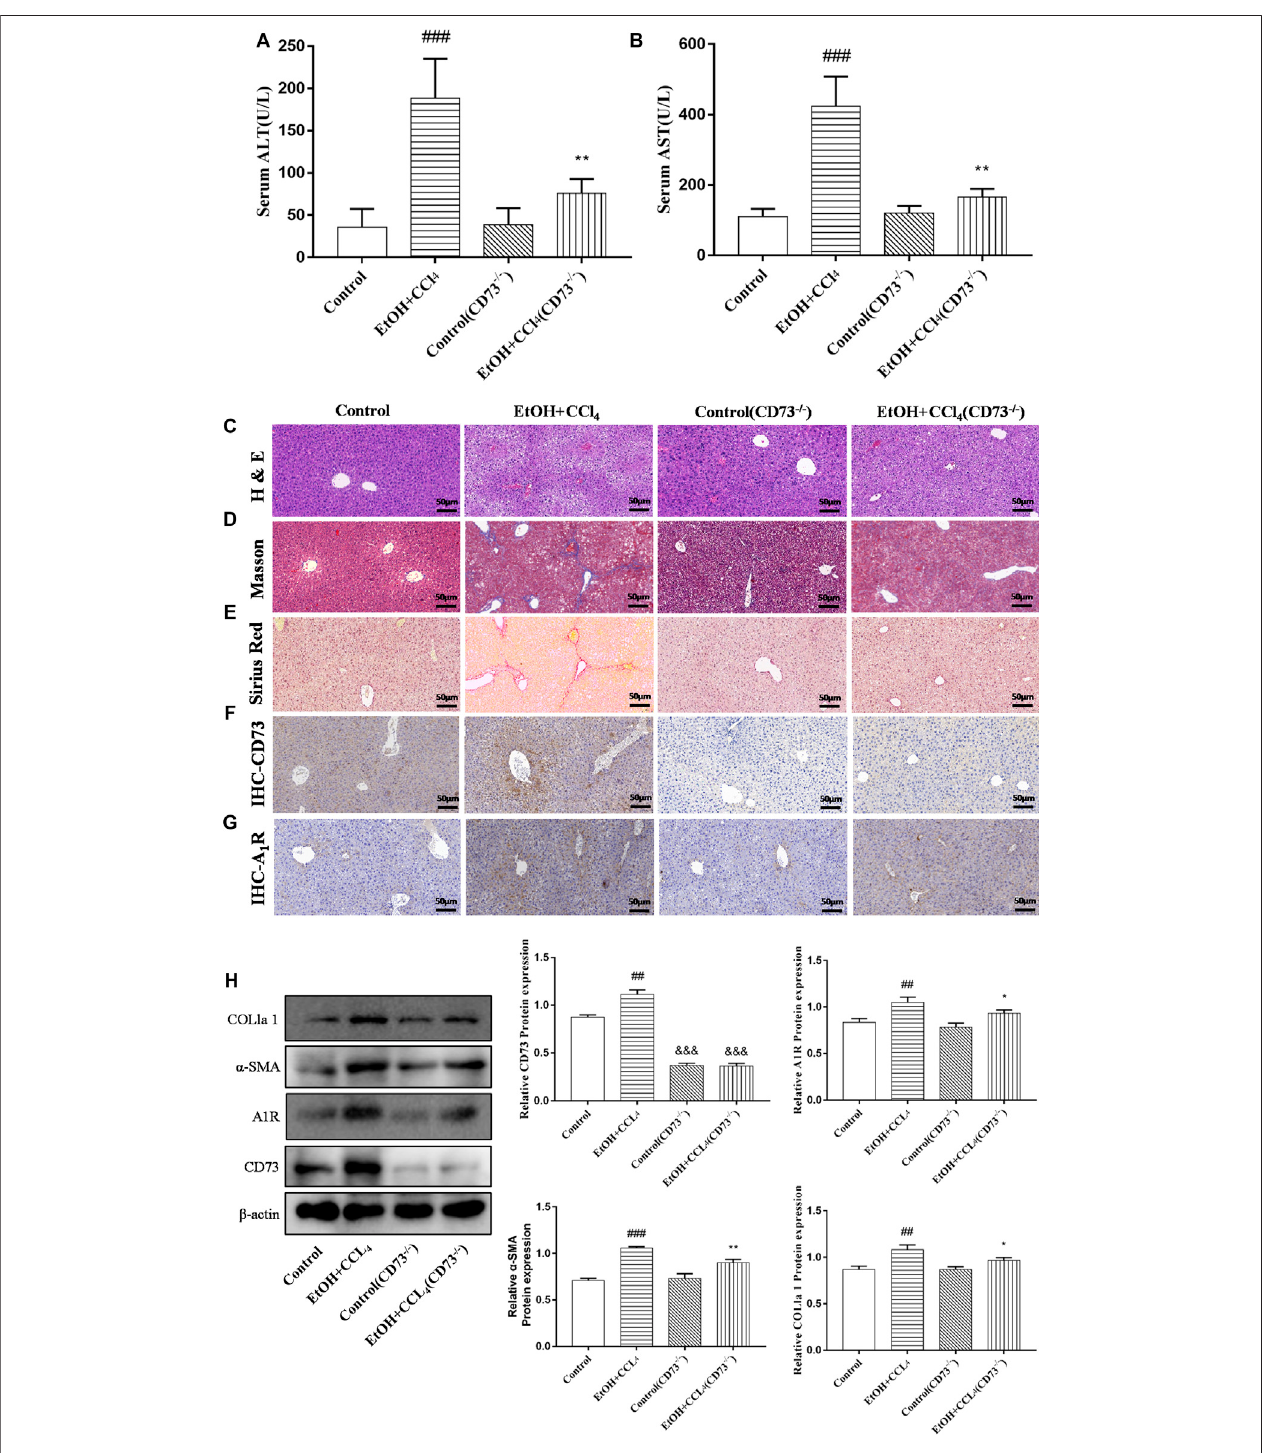
FIGURE 3 | Knockout of CD73 alleviates ALF. (A) Serum ALT level. (B) Serum AST level. (C) Representative HE staining of liver sections (50 μ m). (D) RepresentativeMassonstainingofliversections(50 μ m). (E) RepresentativeSiriusRedstainingofliversections(50 μ m). (F) Immunohistochemical(IHC)stainingofCD73 in liver sections (50 μ m). (G) Immunohistochemical (IHC) staining of A 1 R in liver sections (50 μ m). (H) The protein levels of CD73, A 1 R, α -SMA and COL1a1 in the liver. ## p < 0.01, ### p < 0.001 vs. the control group. *p < 0.05, **p < 0.01 vs. the control (CD73 − / − ) group, &&& p < 0.001 vs. the control group.